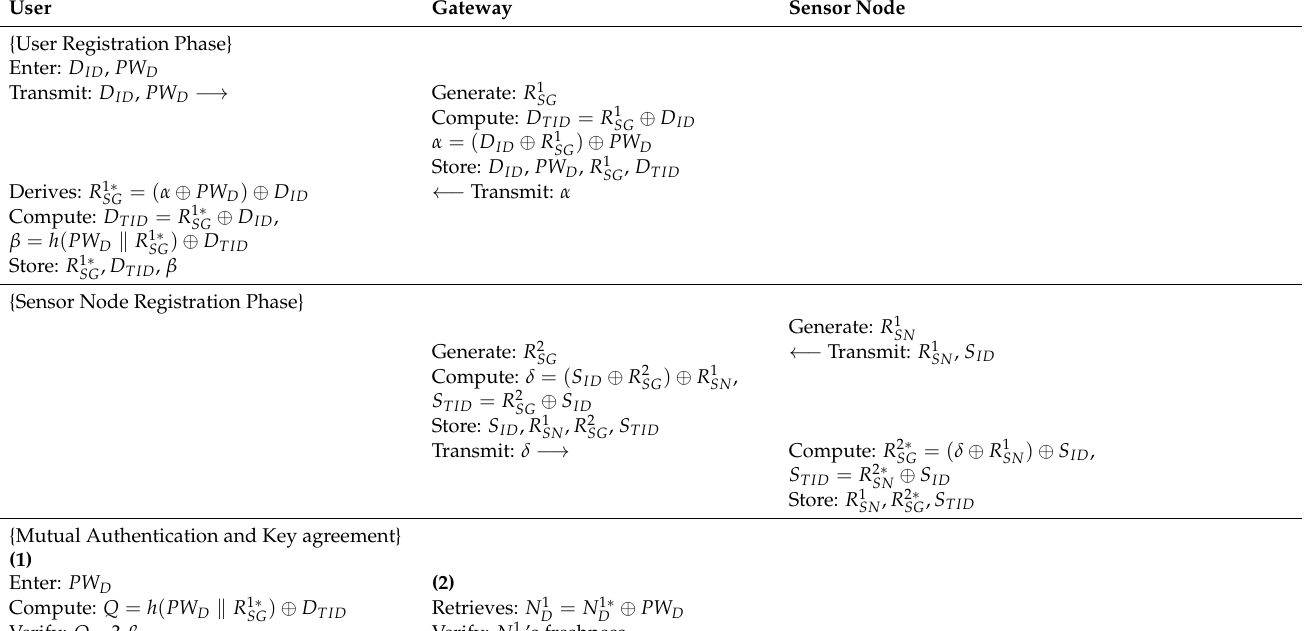
Table 3. Masud et al.’s [6]